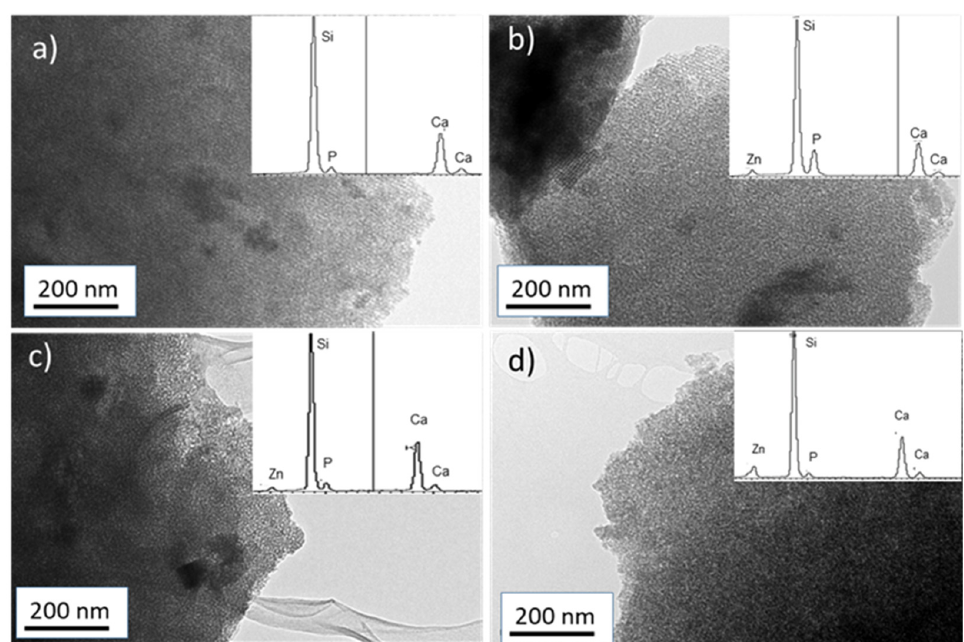
Figure 2. TEM images and EDX spectra obtained for ( a ) MBG, ( b ) MBG-Zn1, ( c ) MBG-Zn3, and ( d )